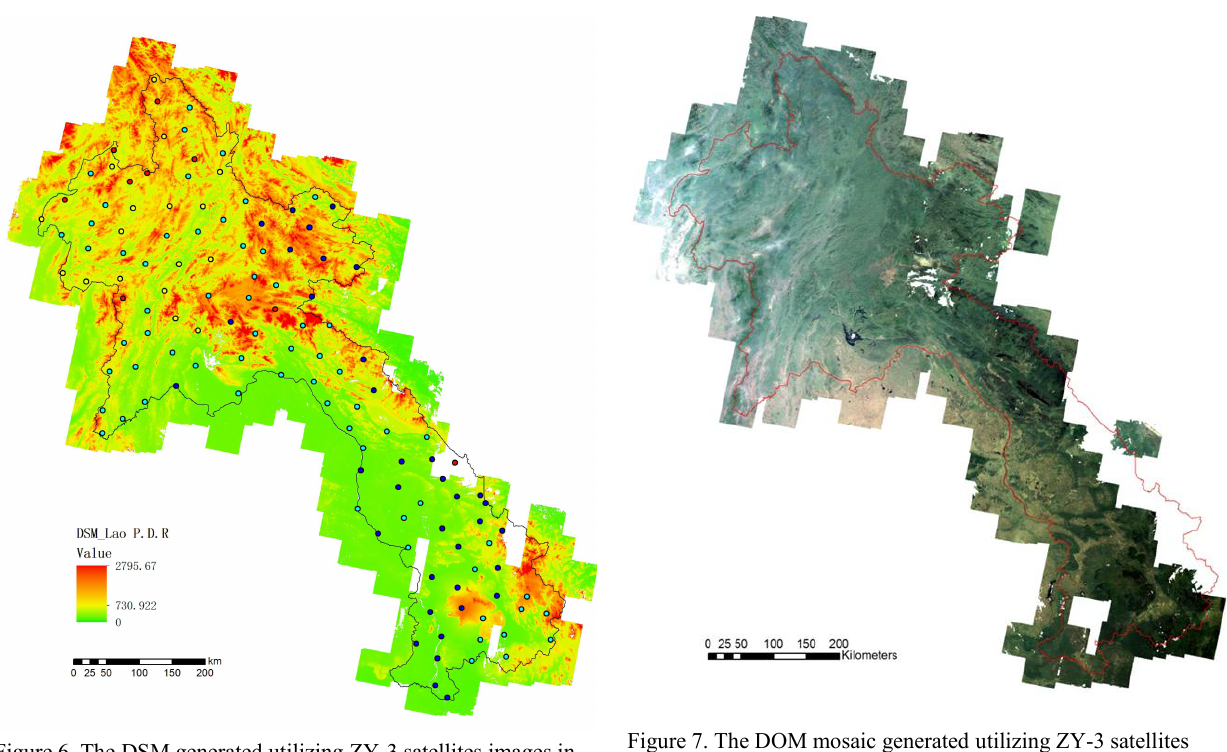
Figure 6. The DSM generated utilizing ZY-3 satellites images in 2012-2018 and the distribution of 131 GPS checking points